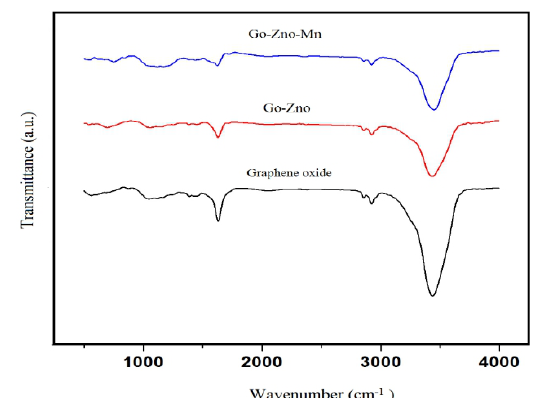
Fig. 3. FTIR Spectra of GO, GO-ZnO, and GO-ZnO- Mn